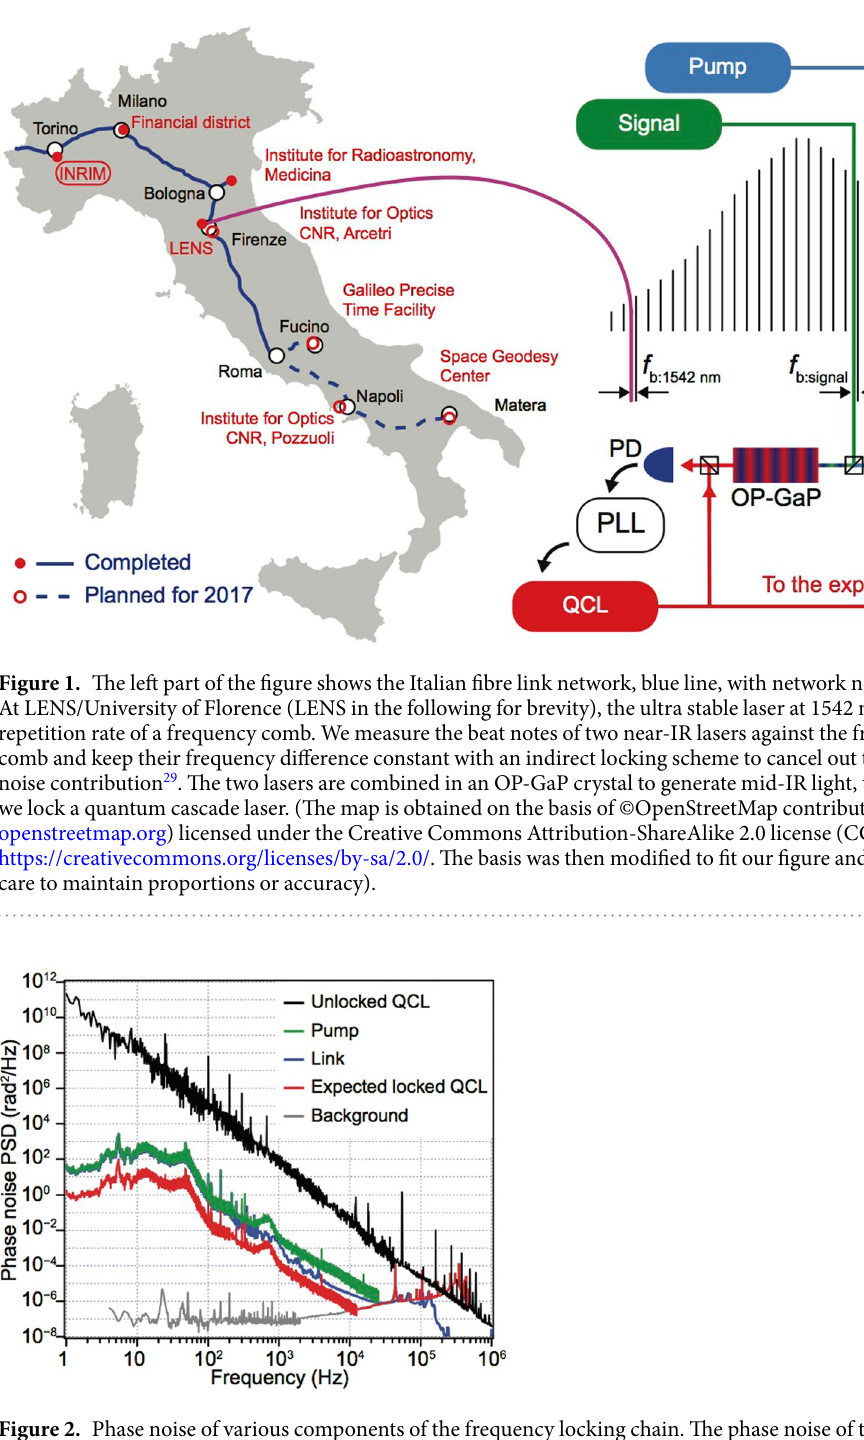
lock of the signal laser to the pump. For this, we use the frequency comb to bridge the gap between the two lasers but we reject its noise contribution by proper processing of f , f , and f 029 . b:pump b:signal To implement this indirect locking scheme, we subtract f 0 from each beat note using analog mixers, obtaining and f . Thus, the absolute frequencies of the two lasers can be written as ν = + N f f f pump pump rep b:pump b:pump b:signal and ν = + N f f , where N pump = 2816363 and N signal = 2302371 are the comb teeth used for the beat signal signal rep b:signal notes. A 14-bit direct digital synthesizer and a mixer generate the signal − f N N f ( /